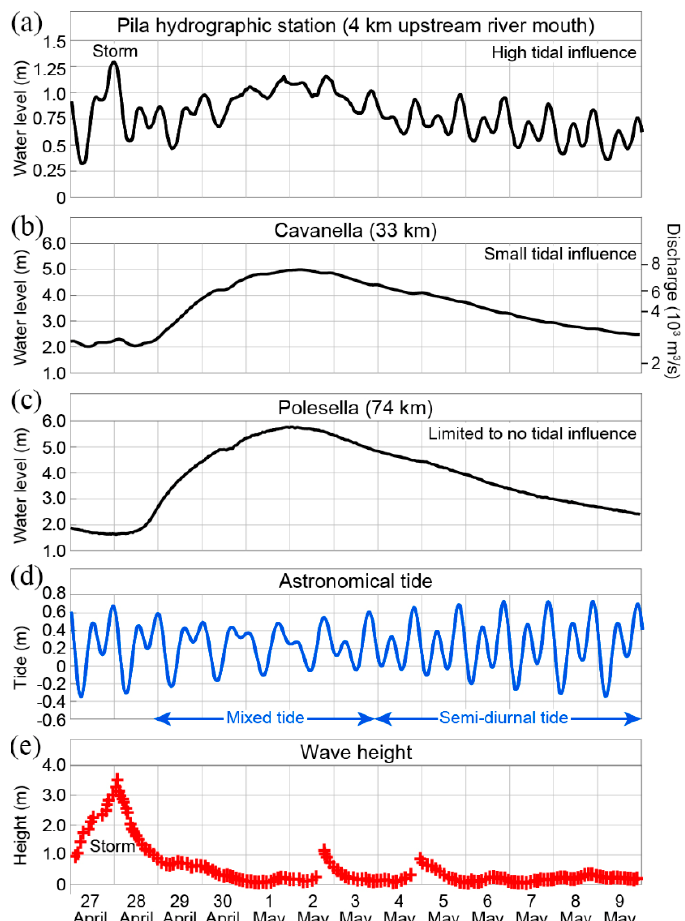
Figure 2. Measured water level and river discharge at the gauging stations of ( a ) Pila, ( b ) Cavanella, and ( c ) Polesella; ( d ) predicted astronomical tidal amplitude and ( e ) wave heights off the Pila distributary mouth.